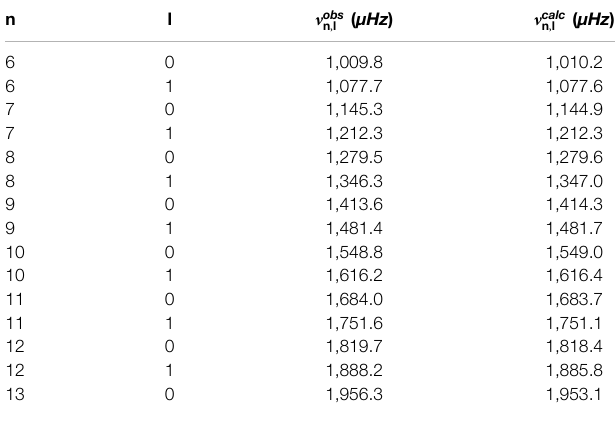
TABLE 1 | Asymptotic behaviour of solar p modes detected with the new transform proposed in this paper. n and l stands for the radial order and angulardegreesofthemoderespectively.Weshowthefrequenciesdetectedwith the quaternion Fourier transform, ] obs n , l , as well as the frequencies calculated with Eq. 23 , ] calc n , l .